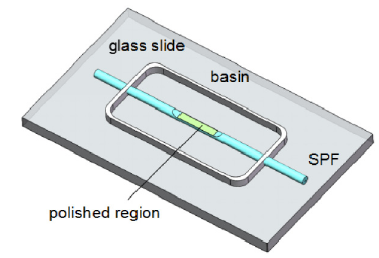
Figure 11. Diagram of a fiber-optic humidity sensor